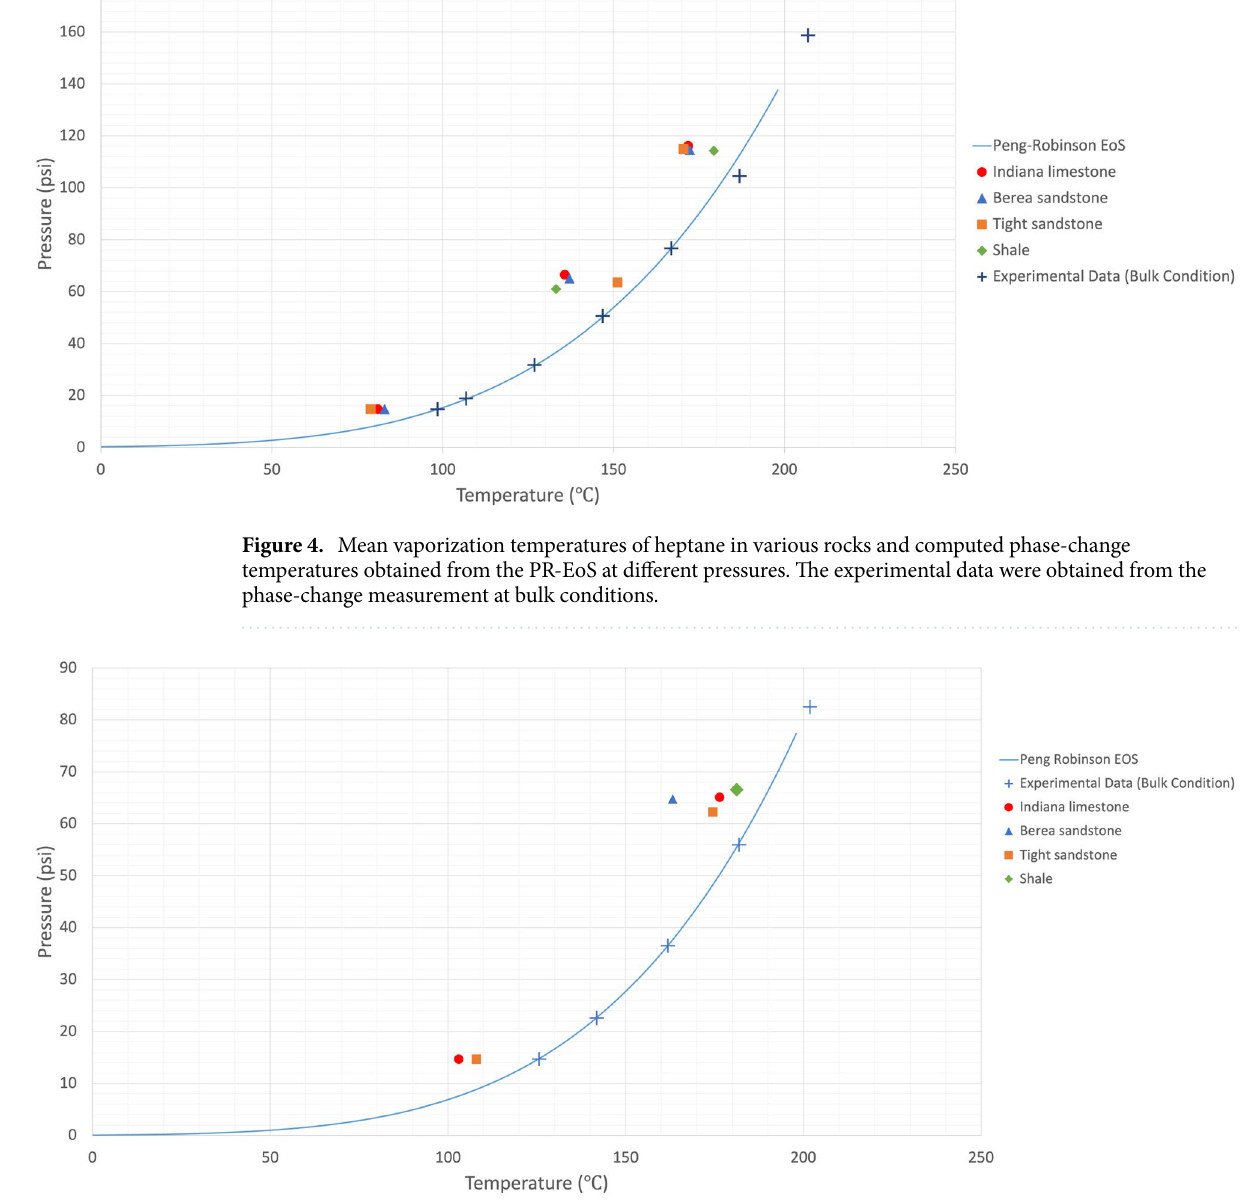
Figure 5. Mean vaporization temperatures of octane in various rocks and computed phase-change temperatures obtained from the PR-EoS at different pressures. The experimental data were obtained from the phase-change measurement at bulk